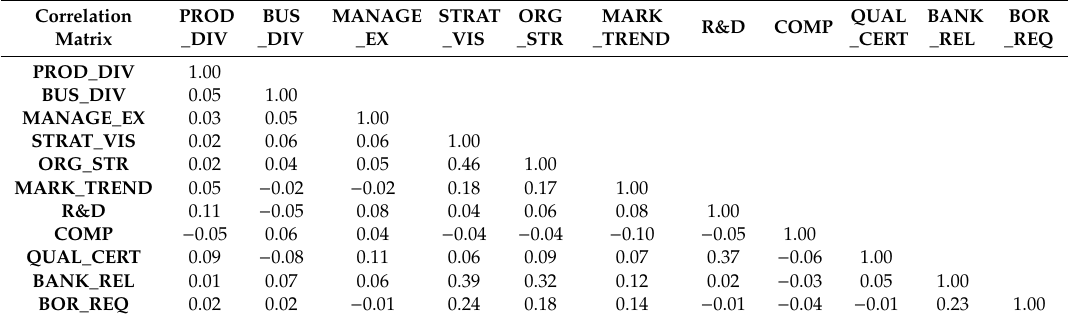
Table 4. Correlation Matrix for Soft